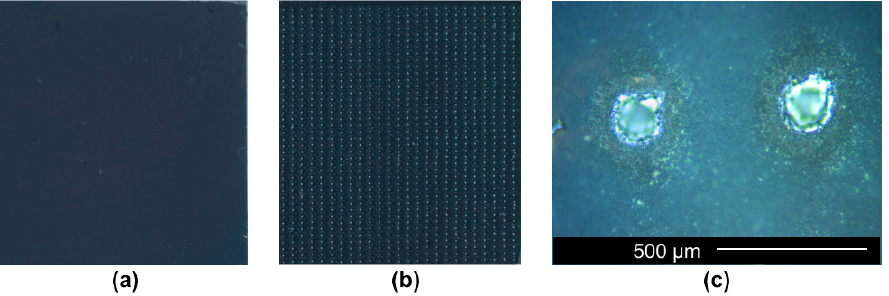
Figure 3. Images of the ordered NW target ( a ) before and ( b ) after interaction with the intense laser pulses. ( c ) optical microscope 50 × magnification image of single-shot damage spots on the disordered NW target.